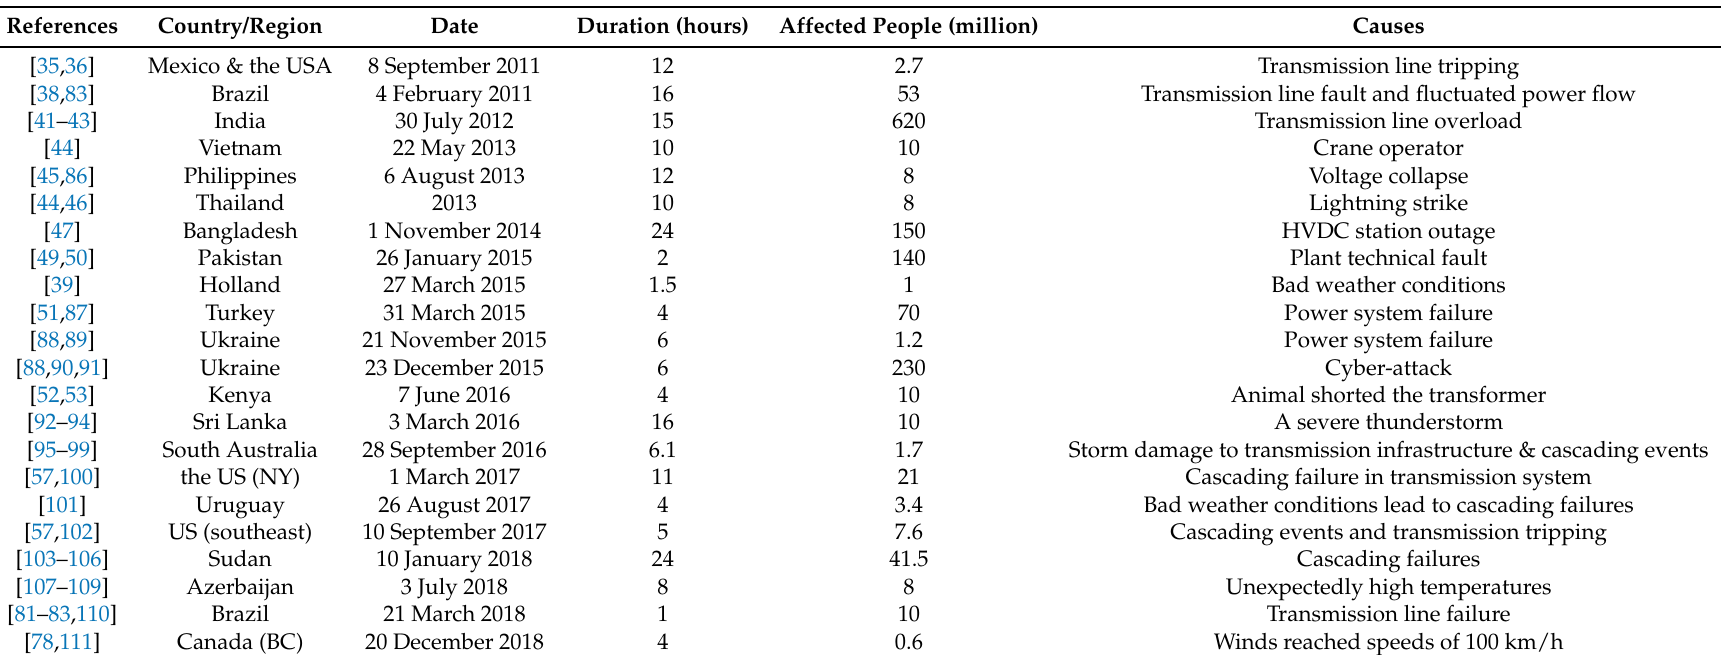
Table 6. A summary of recorded major (most severe) power outages around the globe in this